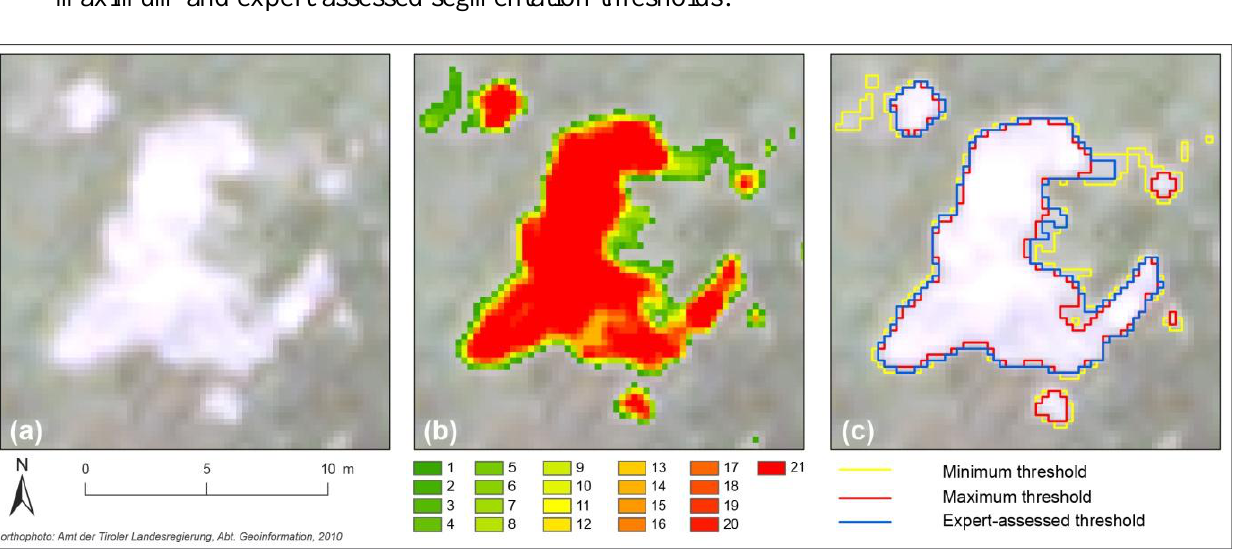
Figure 4. Segmentation steps illustrated on a sample area. ( a ) Eroded area visible within the orthophoto; ( b ) sum image (∑ layer ) combining all 21 layers; ( c ) minimum, delineation maximum and expert-assessed segmentation